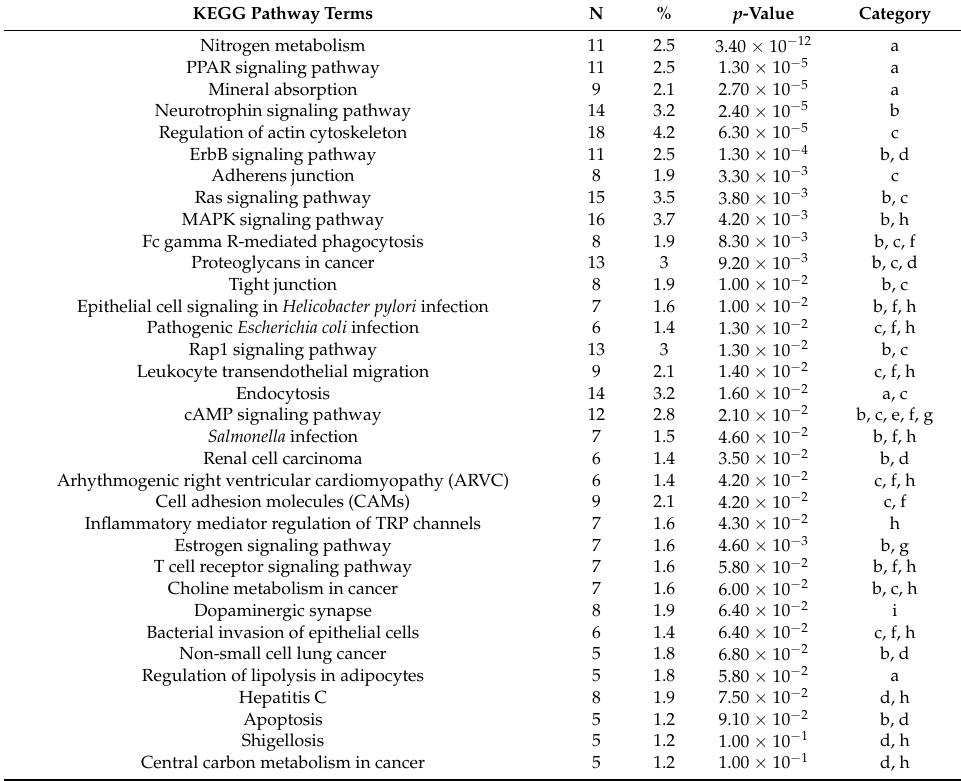
Table 2. The list of 35 cellular/physiological pathways targeted by the enrichment analysis (KEGG Pathways) with DAVID 6.7. The analysis includes results from a list of 429 genes. N = number of genes participating to the KEGG Pathway. % = percentage of genes in the total of 429 genes. Category = represents the general cellular/physiological function to which the KEGG pathway is involved in. The Kegg pathway terms in red are not supported by significant P-values (P > 0.05). Categories: a = Metabolism. b = Cellular differentiation/survival. c = Cellular organization/adhesion. d = Cancer. e = Development. f = Immune response. g = Reproduction. h = Inflammatory processes. I = Neuronal